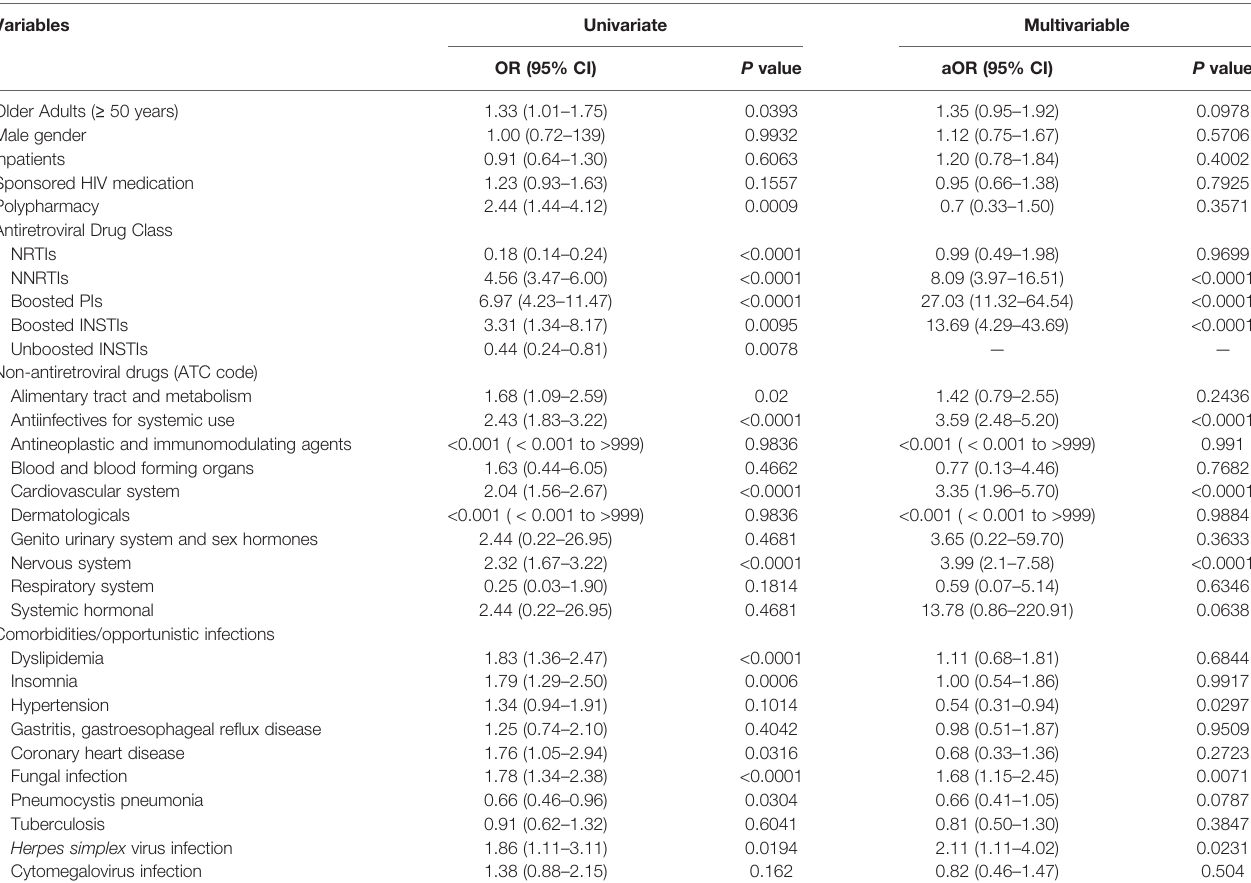
TABLE 3 | Factors associated with potential drug-drug interactions. Variables